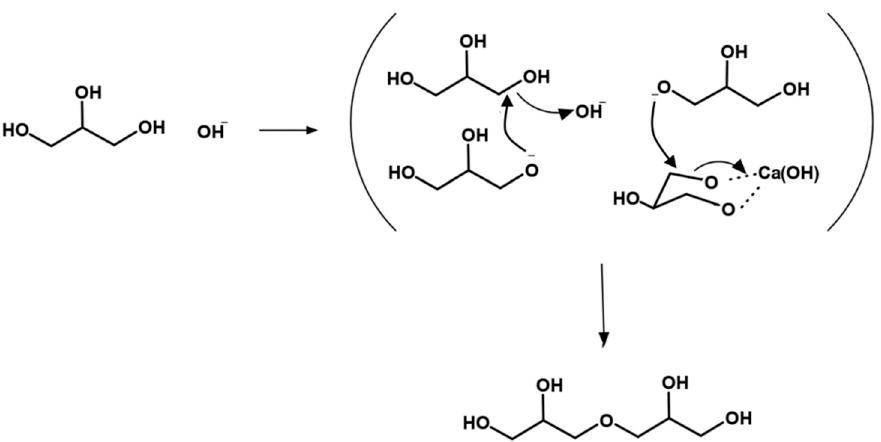
Figure 6. Reaction mechanism for glycerol polymerization with Ca(OH) 2 as a catalyst, with contribution of Ca in the mechanism, as proposed in [40].